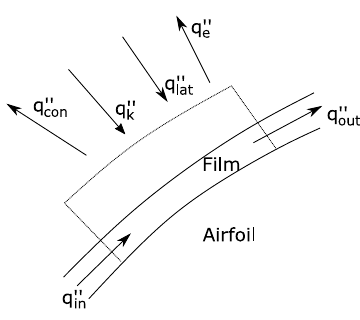
Figure 2. Heat Transfer Control Volume.